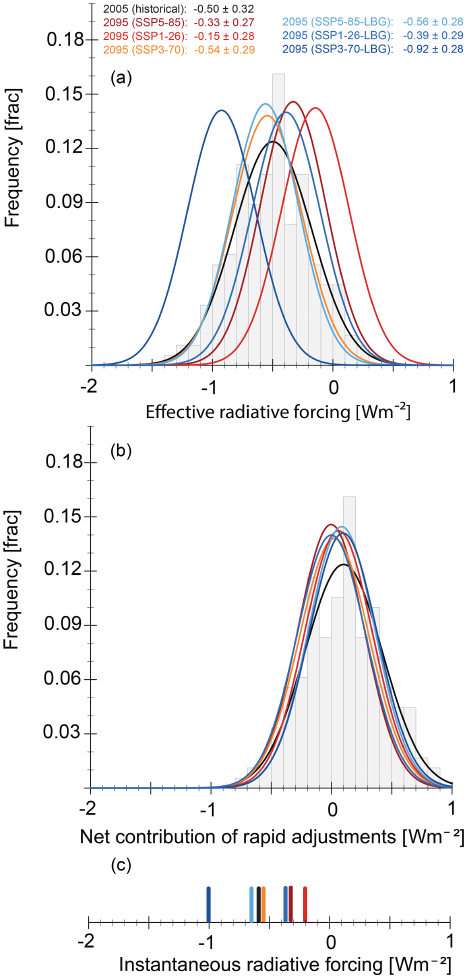
Figure 6. Natural variability in all-sky forcing for the mid-2090s. Shown are the Gaussian distributions of (a) the effective radiative forcing (ERF) and (b) the net contribution of rapid adjustments for the mid-2090s with the standard (orange–red) and the stronger (blue) Twomey effects. The black line marks the mid-2000s values from Fiedler et al. (2017) with the frequency histogram in grey. The distributions are based on annual means for all-sky condition in the shortwave spectrum (SW) at the top of the atmosphere (TOA). The long-term means ± year-to-year standard deviation of annual ERFs are listed at the top. The year-to-year standard deviation illustrates the impact of natural variability internal to the model for estimating ERF, in contrast to the (c) annual means in the instantaneous radia- tive forcing (RF) that are not strongly affected by natural variability.